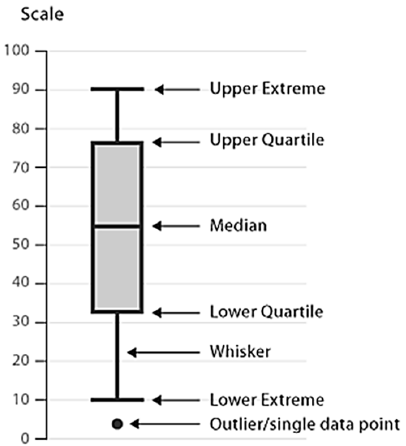
Figure 7. Example of application of box and whisker principle.